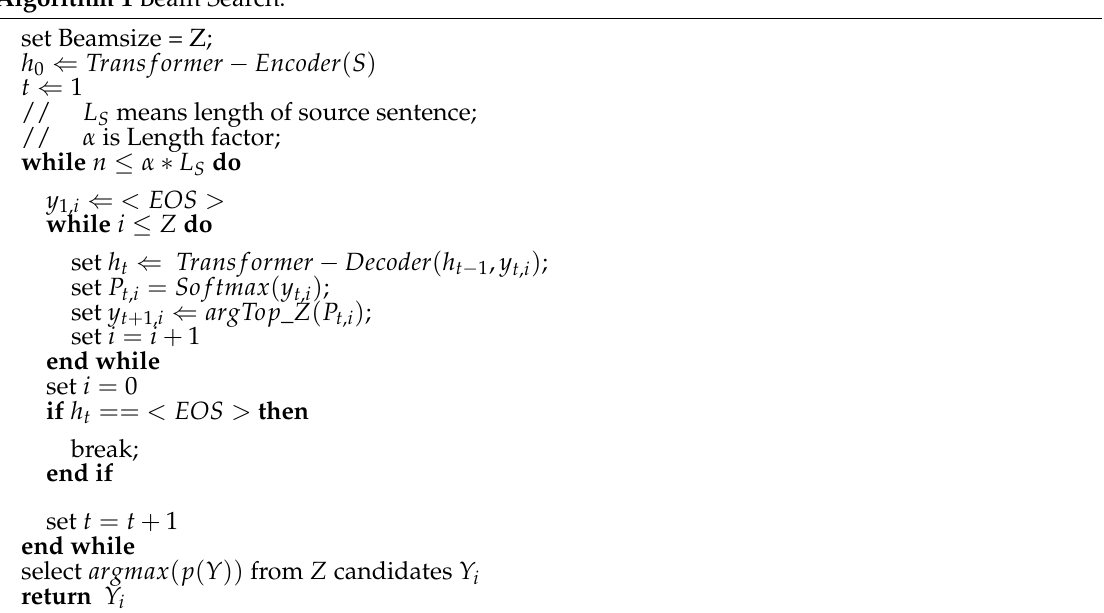
Algorithm 1 Beam